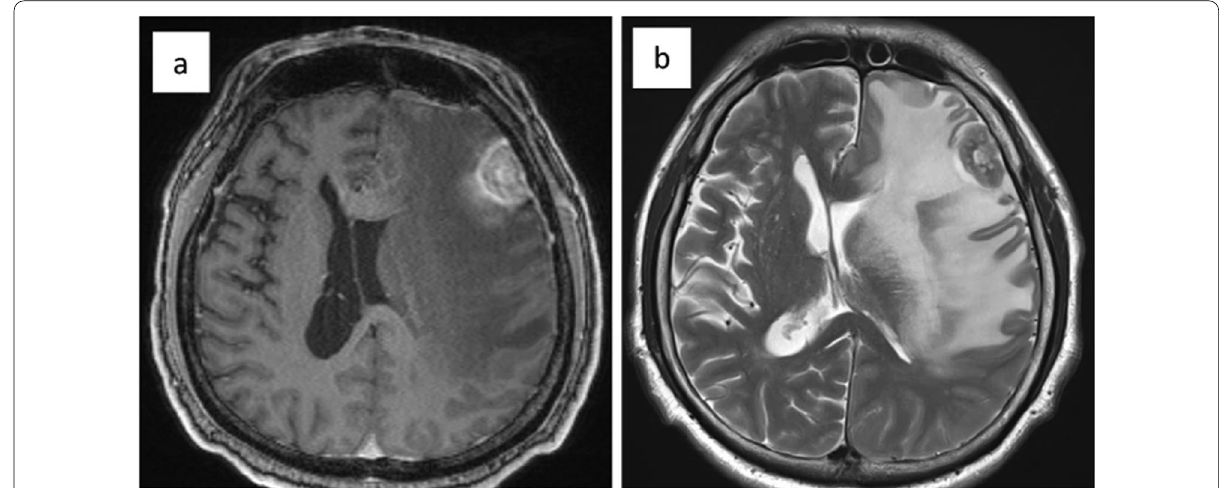
Fig. 1 Magnetic resonance imaging of the brain tumor. a T1-weighted image showed a nodular lesion (diameter 13 the left frontal lobe. b T2-weighted image of a high signal area in the surrounding white matter with median